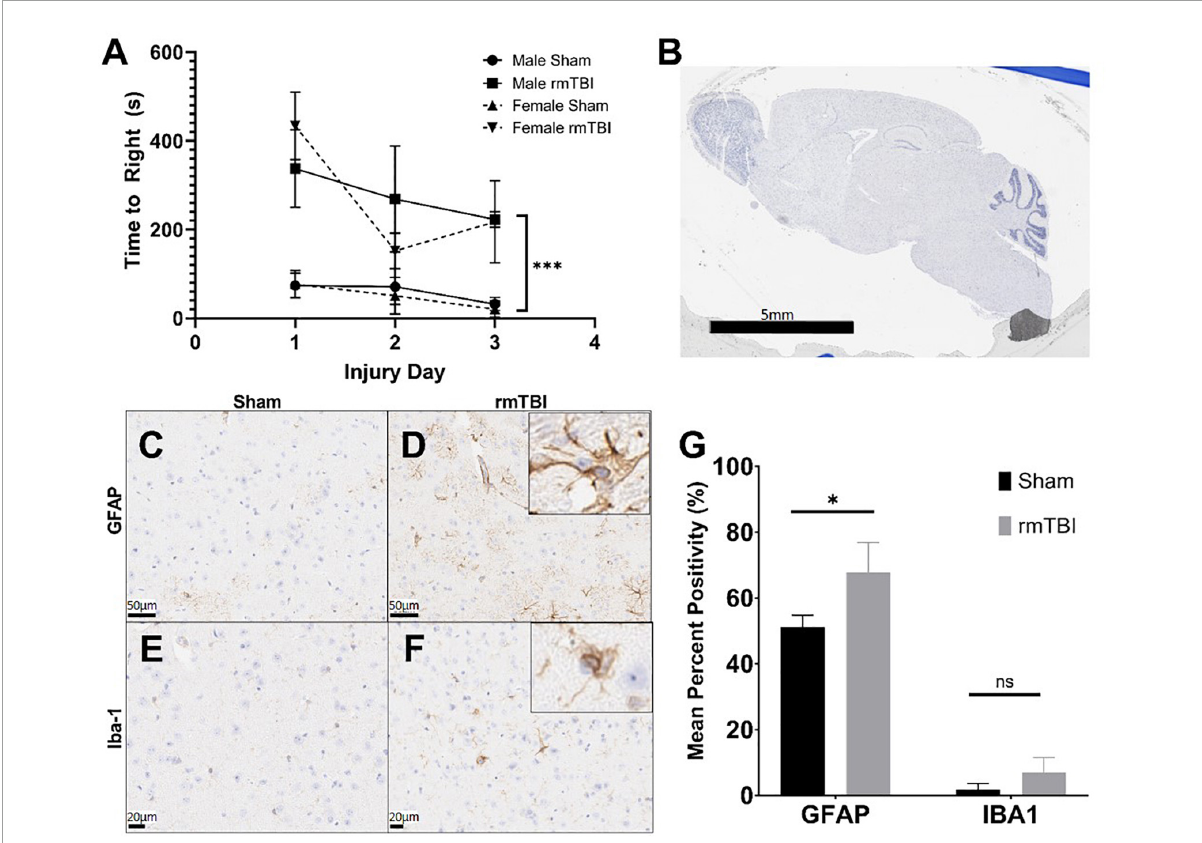
FIGURE1 Injury induced by closed skull impact model is mild. The injury induced by the presented model can be deemed mild, as indicated by righting reflex measured immediately after injury. rmTBI mice took significantly longer to right than shams (A) on each day with sex having no effect ( p < 0.001, main effect of injury and main effect of day, three-way ANOVA, n = 6 per group). Also supportive of a mild injury, despite the absence of any gross lesion (B) , rmTBI mice showed significantly increased GFAP staining ( p = 0.04, unpaired t -test, n = 4 per group) (C,D,G) , and an increase in lba-1 staining that did not reach statistical significance ( n = 4 per group) (E–G) in the cortical region near impact. Error bars represent standard deviation. Indication of statistical significance is as follows: ∗ p <